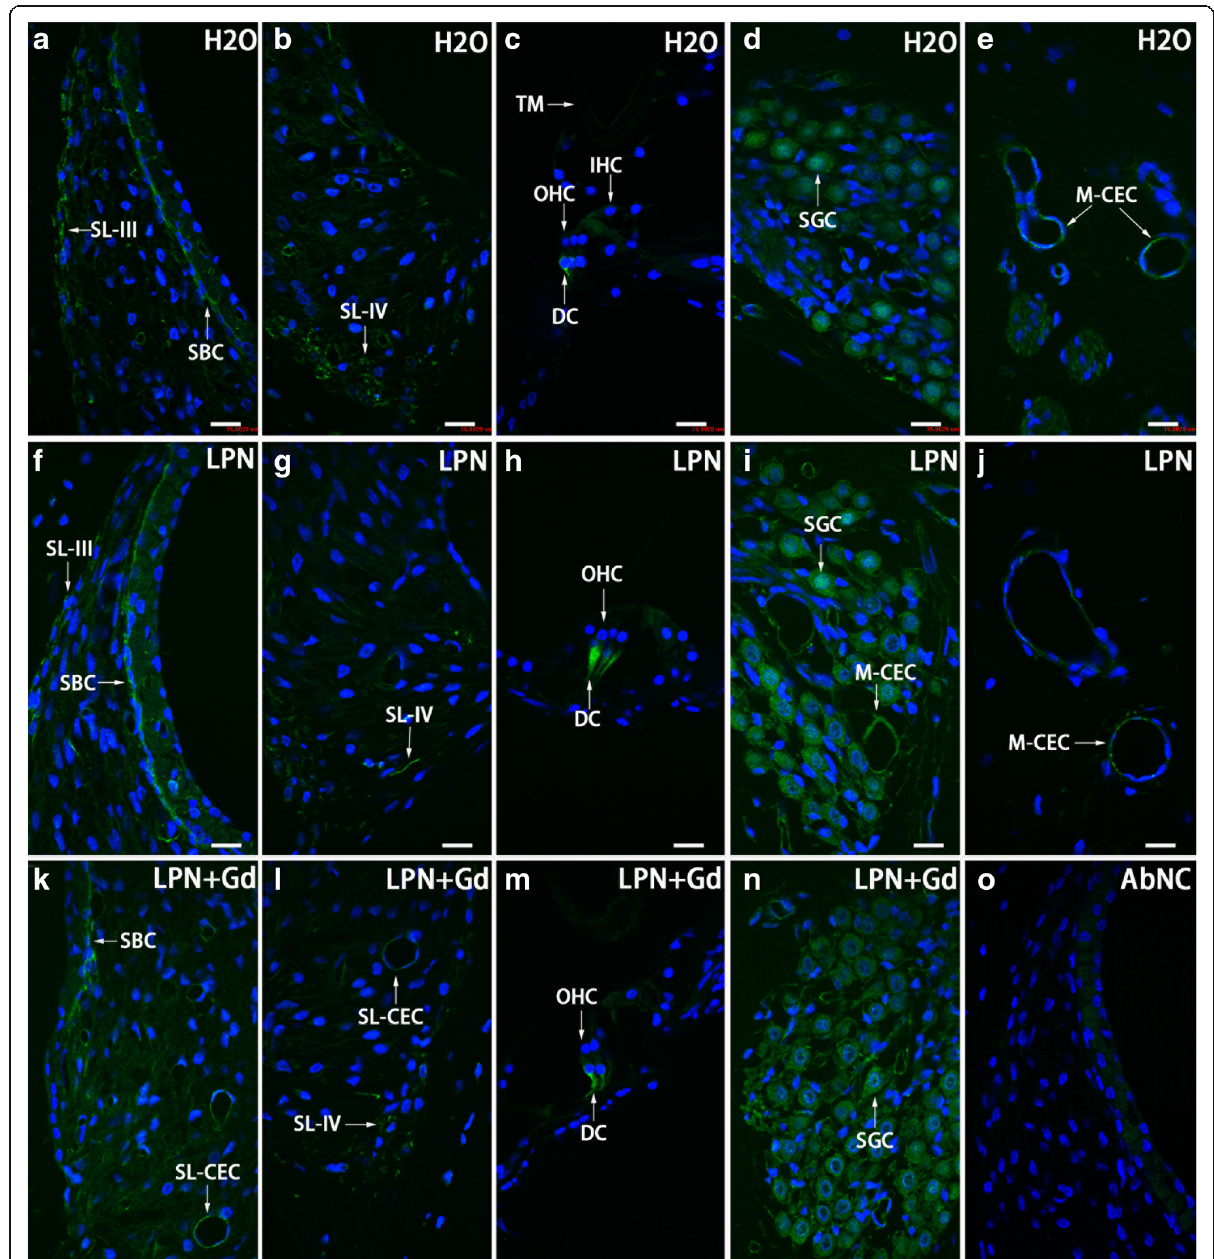
Fig. 9 CD44-positive cell distribution in the rat cochlea exposed to liposome nanocarrier demonstrated using immunofluorescent confocal microscopy. CD44-positive cells were mainly detected in the stria basal cell ( SBC ), spiral ligament ( SL ), Dieter ’ s cells ( DC ), spiral ganglion cell ( SGC ), and capillary endothelial cell ( CEC ) in the groups of negative control ( H2O ) ( a – e ), empty liposome nanocarriers ( LPN ) ( f – j ), and Gd-DOTA-containing LPN ( LPN+Gd ) ( k – n ). There was no staining in the antibody omitted negative control ( AbNC ) ( o ). IHC inner hair cells, M-CEC capillary endothelial cell in modiolus, SL-CEC capillary endothelial cell in spiral ligament: spiral ganglion cells, SL-III spiral ligament fibrocyte type III, SL-IV spiral ligament fibrocyte type IV, TM tectorial membrane, OHC outer hair cells. Scale bar =16 μ was not affected by the administrations of LPNs and reduced the secretion of hyaluronic acid in the spiral LPN + Gd-DOTA. The impact of LPNs on the hyalur- ligament fibrocytes. The expressions of CD44 and TLR2 onic acid distribution in rat cochlea did not cause either were not changed after the transtympanic injection of ei- permeability change or hearing loss, indicating that the ther LPNs or LPN + Gd-DOTA. The total glycosamino- modification is unharmful. It was reported that glycan, which contains hyaluronic acid in the cochlea